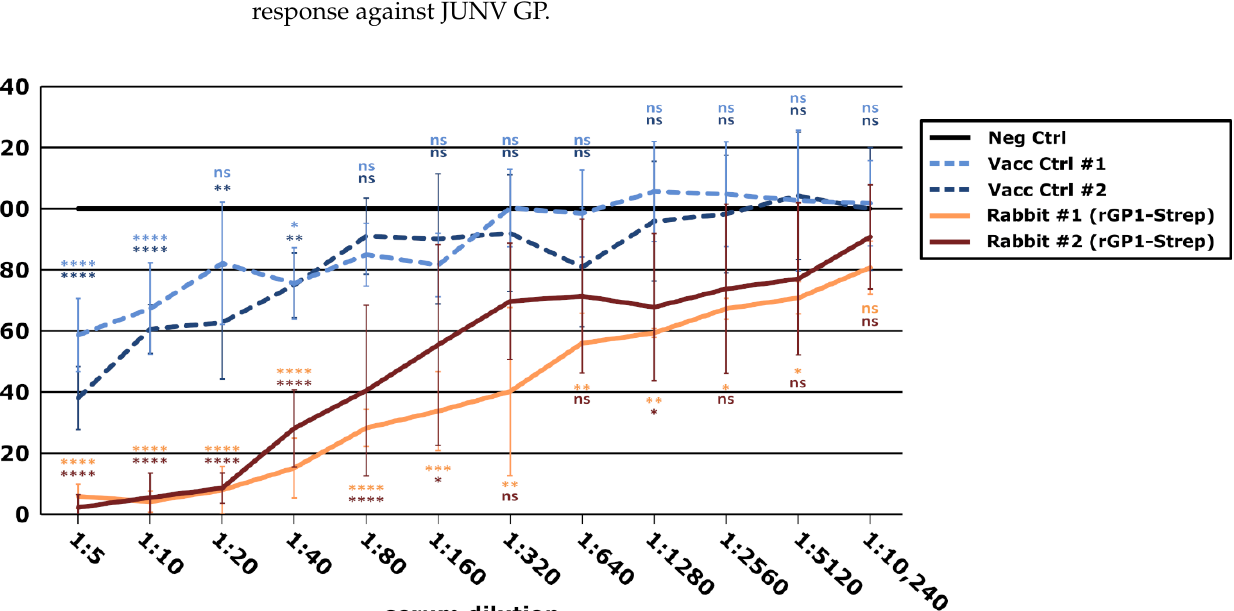
11 of 20 Figure 4. Assessment of neutralizing antibody development following vaccination with recombi- nant Junín virus (JUNV) GP1 based on neutralization of transcription and replication-competent